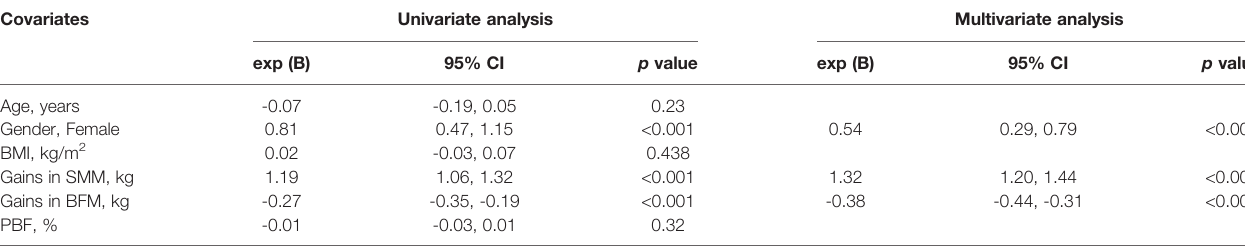
TABLE 2 | The linear regression analysis of height gain and its correlative factors. Covariates